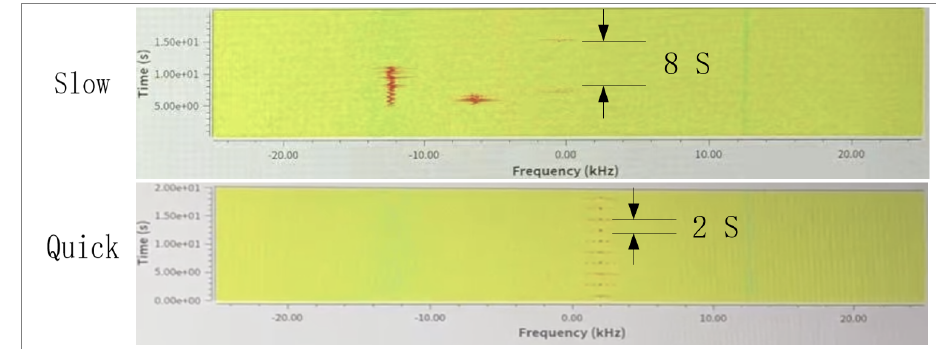
Figure 19. Short and long intervals schematics diagram.